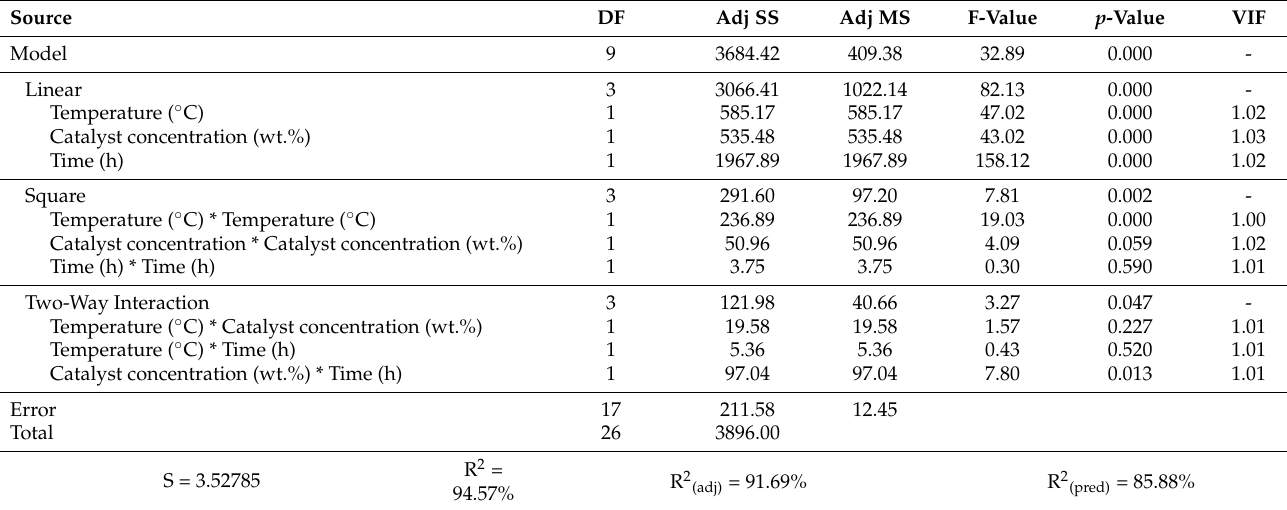
Table 2. Analysis of variance of dimethyl